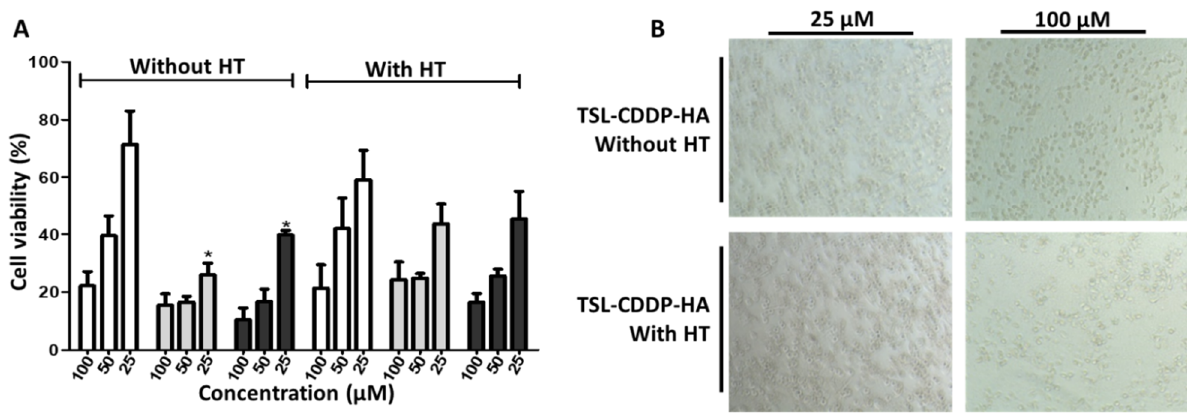
Figure 1. ( A ) Cell viability of MDA-MB-231 after treatment with free CDDP (white bars), TSL-CDDP (gray bars), and TSL-CDDP-HA (black bars) formulations without and with HT, at concentrations of 25, 50, and 100 µM. ( B ) Brightfield microscopy images, 20× objective, after 48 h of treatment with the formulation TSL-CDDP-HA, with and without HT. Data are expressed as mean ± error of three independent experiments. * Represents a significant difference when compared to free CDDP ( p < 0.01, Bonferroni’s test). Table 2. IC50 and confidence interval in MDA-MB-231 cell lines. Treatments Without Treatments